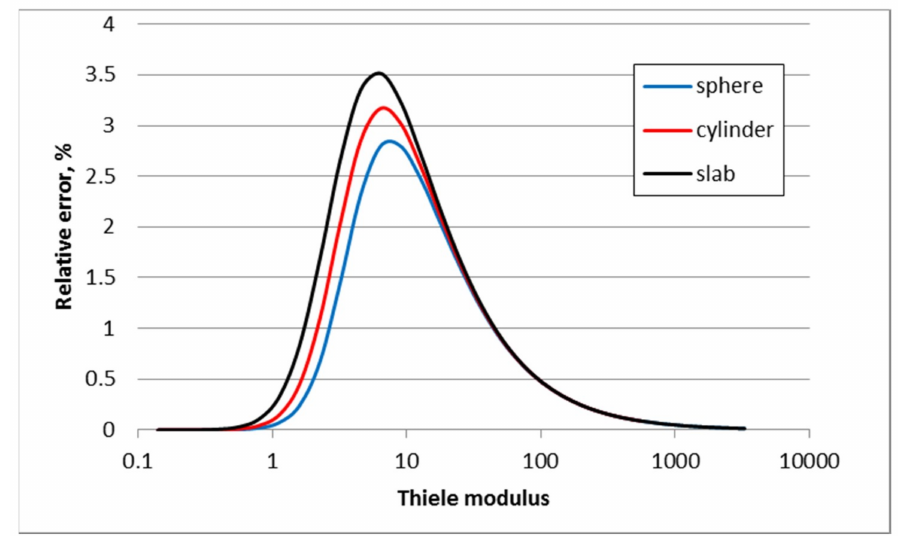
Figure 1. Relative errors in the effectiveness factors for the three standard geometries as functions of Thiele